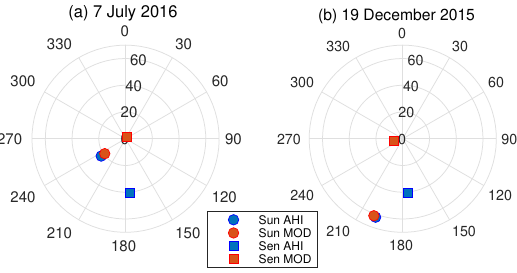
Figure 6. Angular conditions in the polar plot for results obtained for 7 July 2016 ( a ) and 19 December 2015 ( b ) in the Tokai region. Sun and Sen in the legend corresponds to the solar and sensor-view angle conditions. MOD in the legend corresponds to the